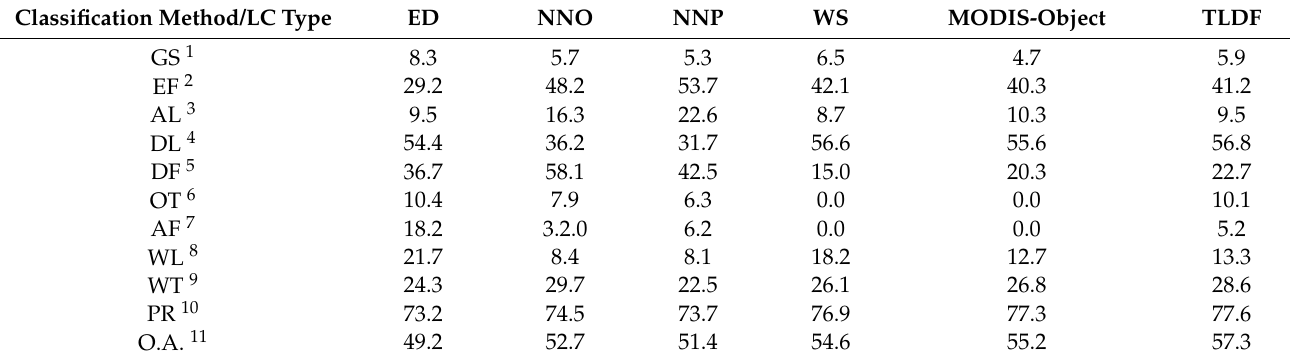
Table 2. Test accuracy of CA i and overall